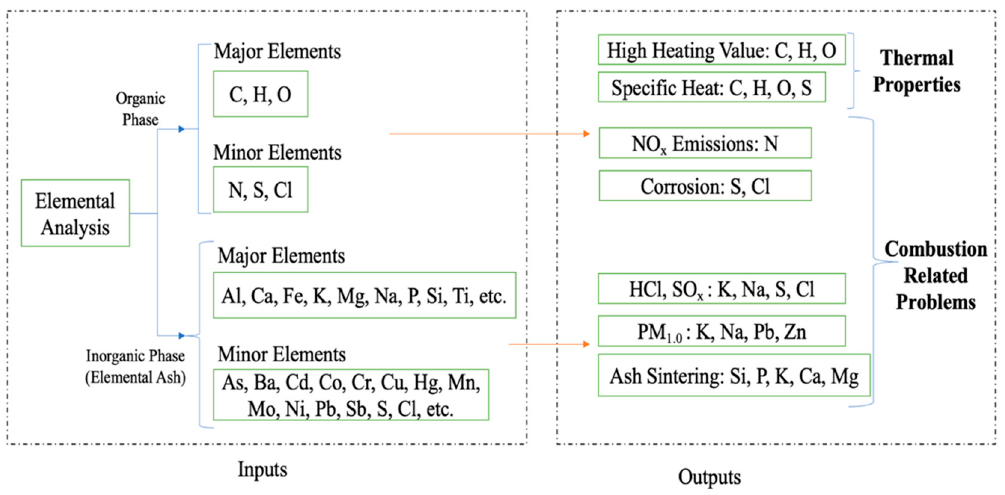
Figure 1. Thermal properties and combustion related problems